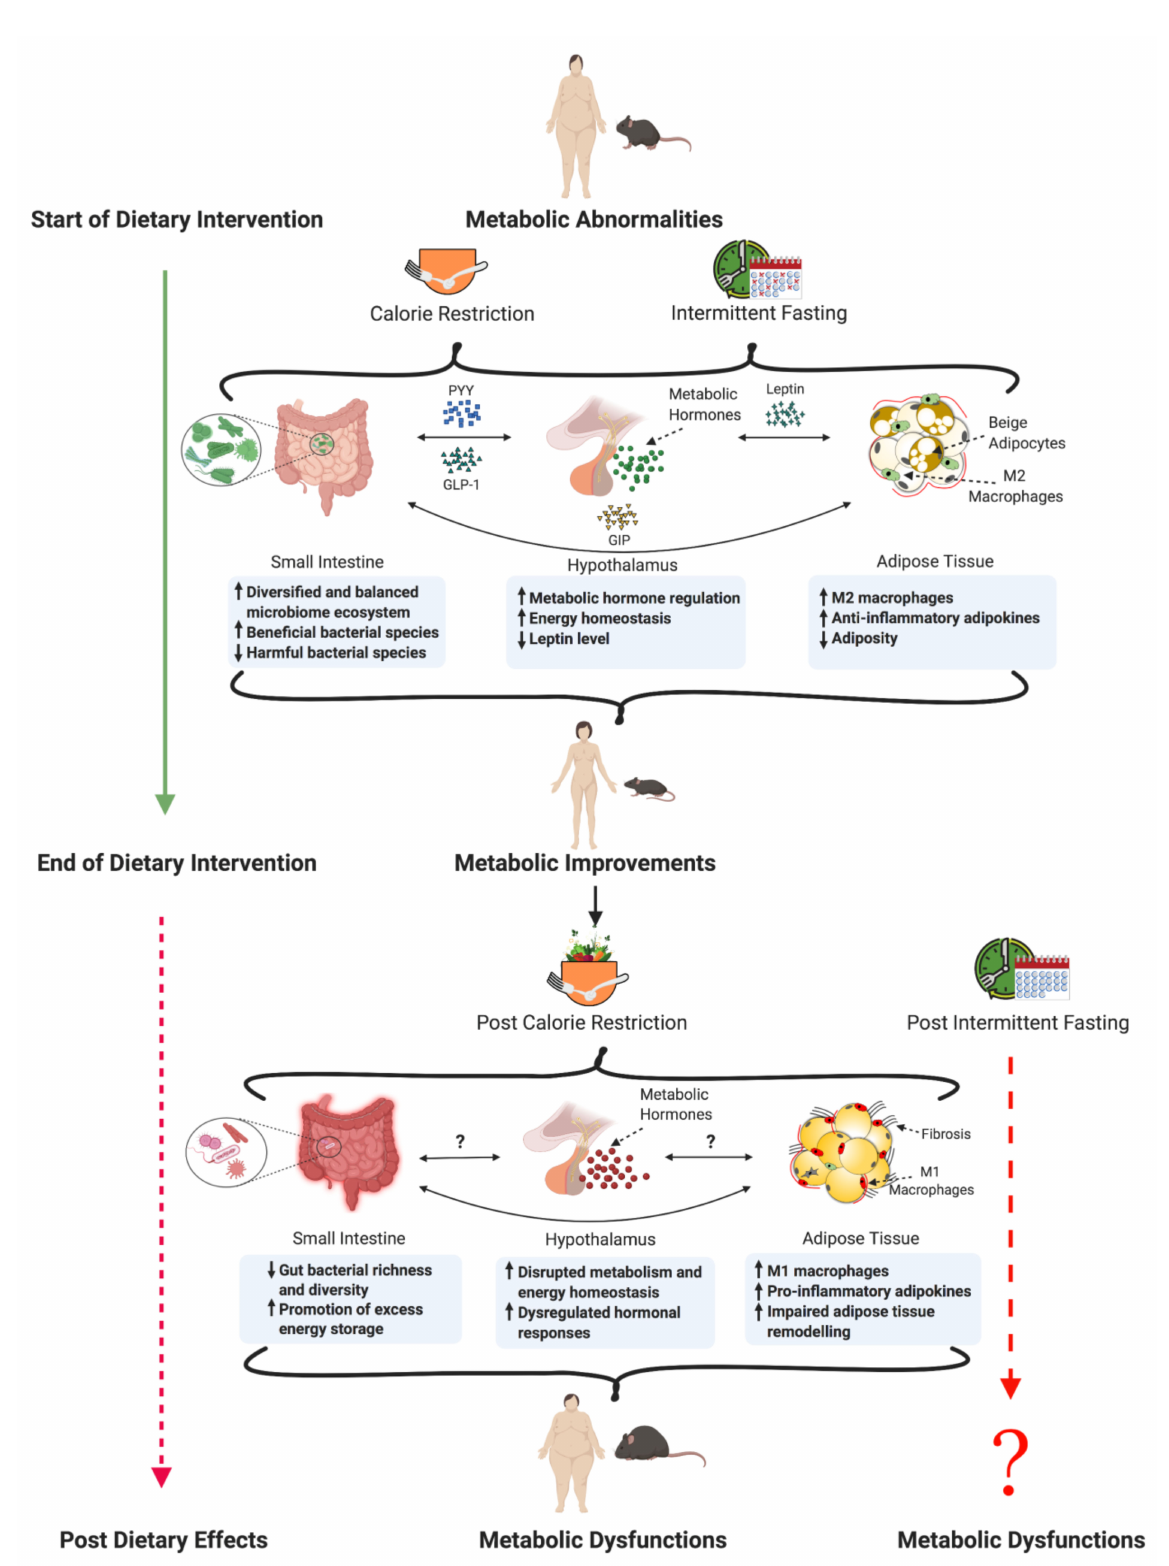
Figure 1. Schematic diagram summarizing the metabolic post-diet effects of CR and IF regimens in mouse and human studies. (Created with